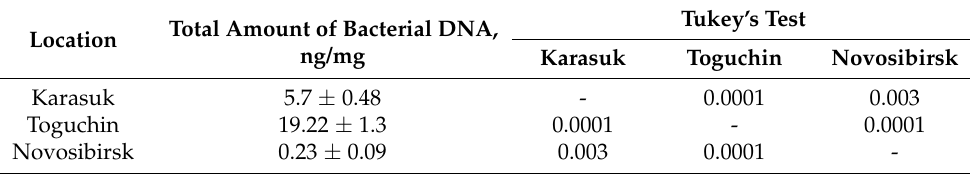
Table 1. Total amounts of bacterial DNA in soils of potato fields with different levels of fungistasis and different agricultural practices: Karasuk (kitchen gardens, high fungistasis), Toguchin (kitchen gardens, intermediate level of fungistasis), and Novosibirsk (conventional fields, low fungistasis).